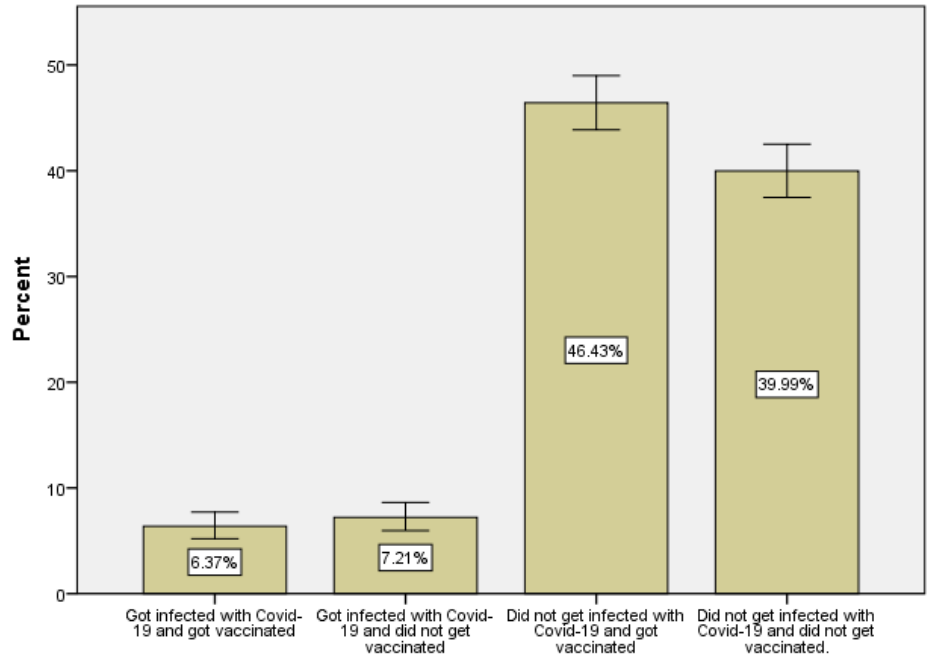
Figure 1. Distribution of vaccination and COVID-19 infection status for adult Palestinians living in the West Bank region of Palestine.